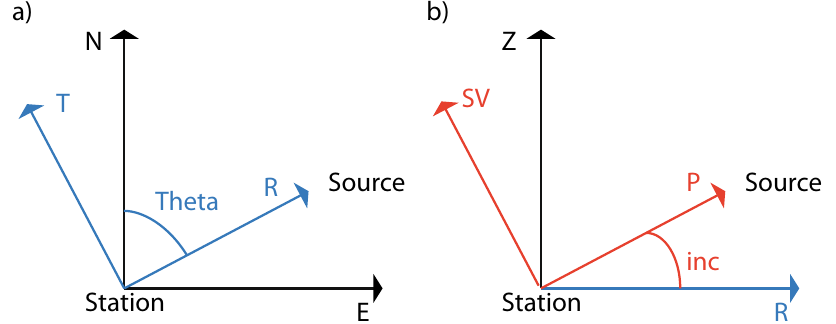
Fig. 4 Rotation to the (P, SV, T) coordinate system. Rotation process to convert the seismograms from the (N, E, Z) coordinate system fi rst to a the (R, T, Z) coordinate system where "Theta" denotes the azimuth and then to b the (P, SV, T) coordinate system where "inc" is the incident angle of the P wave.